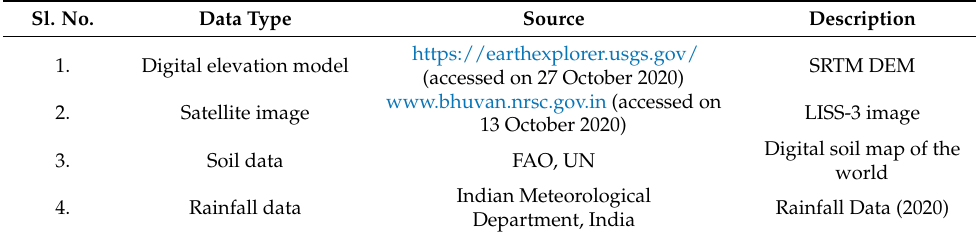
Table 1. Overview of data source.